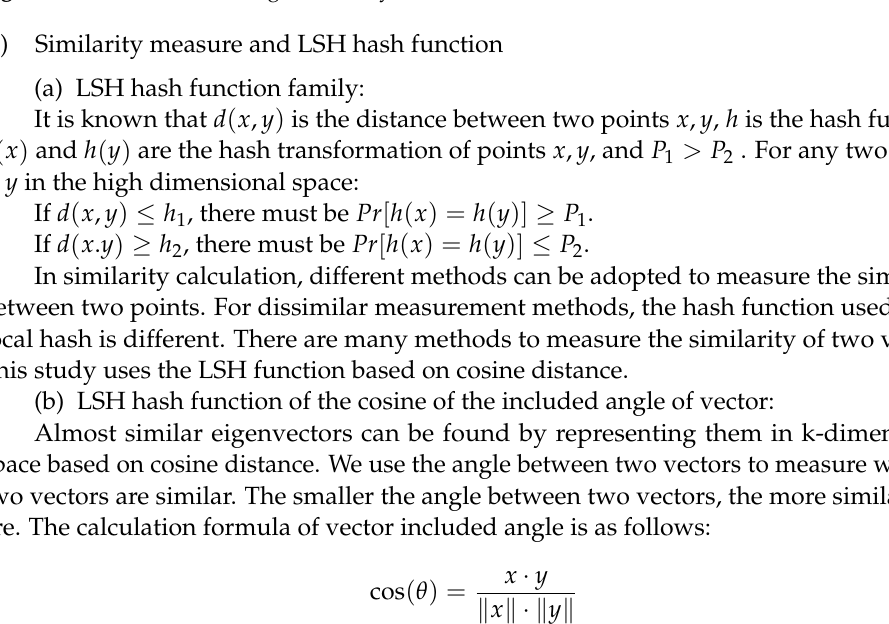
Figure 7. Hash code and image